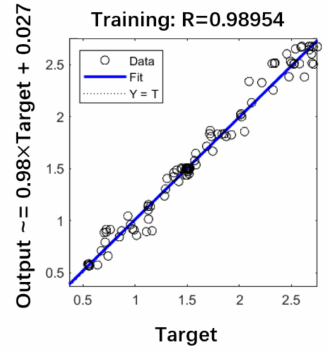
Figure 17. The training accuracy.